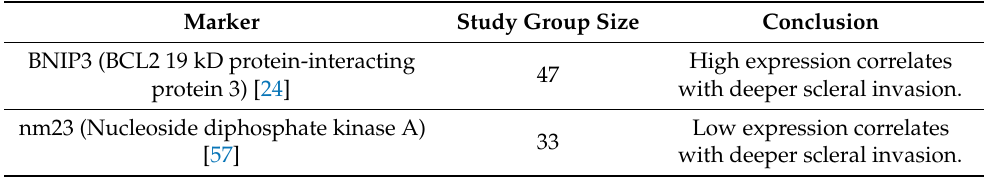
Table 4. Summary of markers whose expression is related to scleral and extrascleral infiltration. Marker Study Group Size